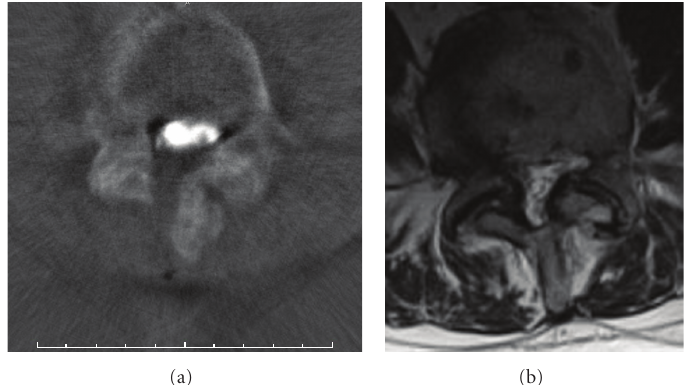
Figure 2: (a) Axial reconstruction with myelography demonstrating decompression from the left side with intraoperative myelography and insu ffi cient decompression of the recess on the right side. (b) Preoperative MR image of the same patient as in